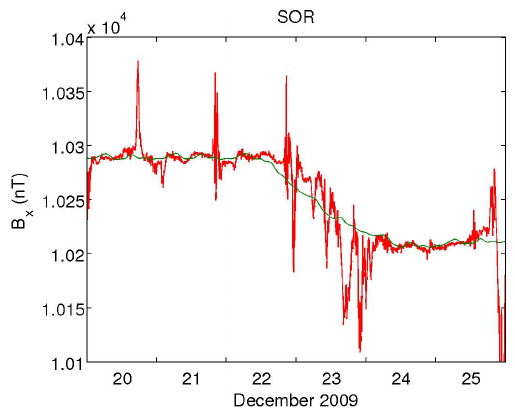
Fig. 10. B x field at Sørøya from 20 to 25 December 2009, and the corresponding baseline derived as described in this